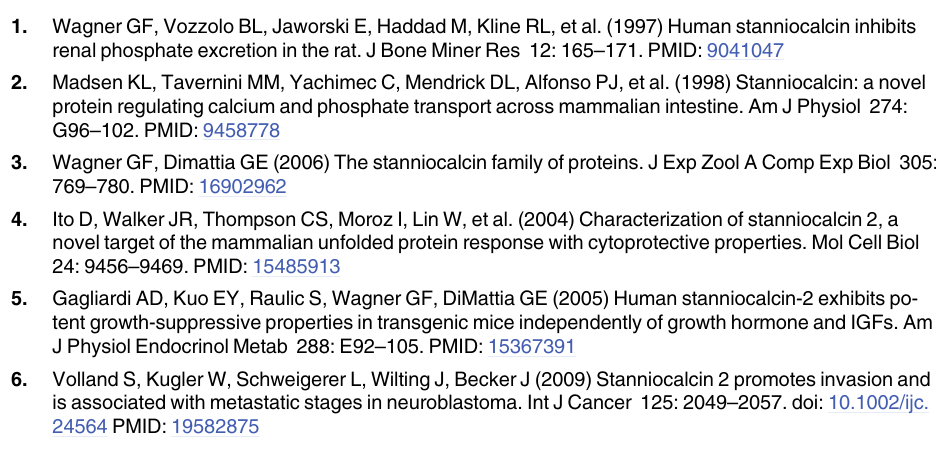
S1 Fig. Analysis of the expression levels of proteins in PI3K/Akt or Ras/Erk pathways.